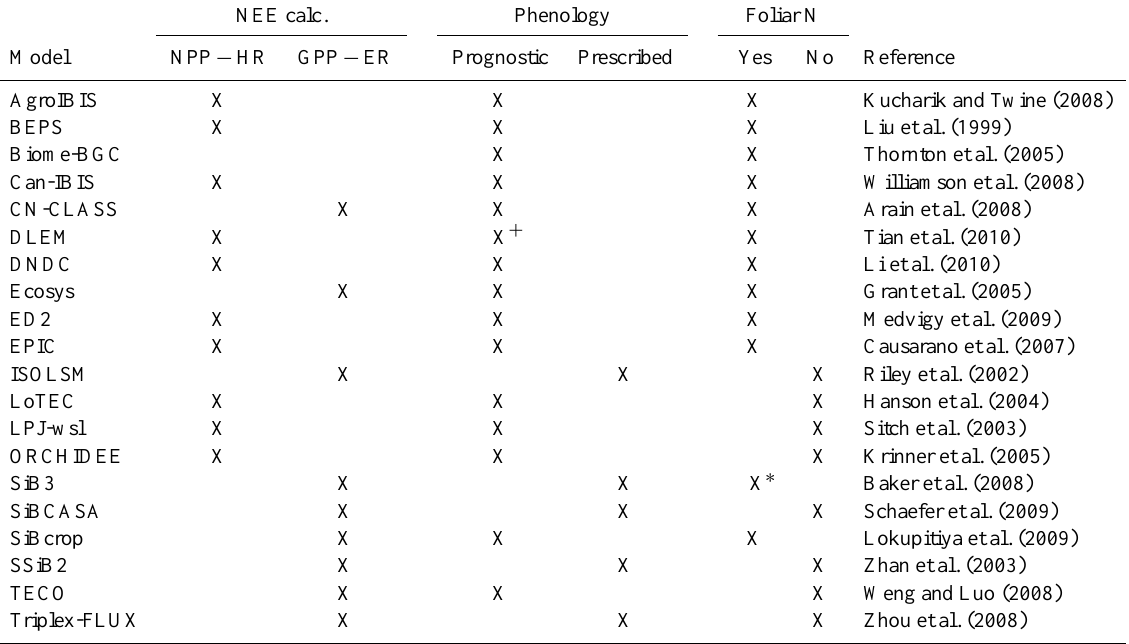
Table 2. A list of model attributes per model following Schwalm et al. (2010). Model/attribute combinations with no checked boxes indicate that a different formulation was used. These are not considered here. ER: ecosystem respiration; GPP: gross primary productivity; HR: heterotrophic respiration; NEE: net ecosystem exchange; NPP: net primary productivity. NEE